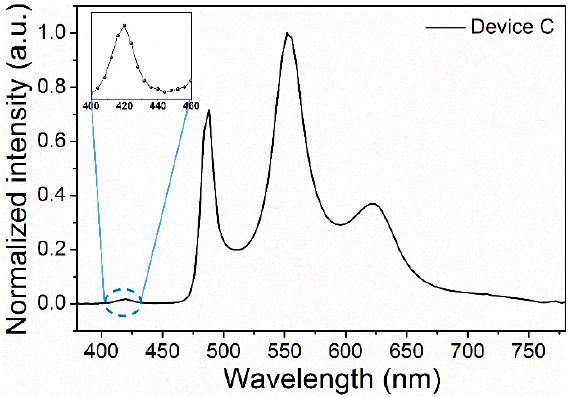
Figure 8. EL spectrum of device C (inset is the magnified first emission peak of the spectra).